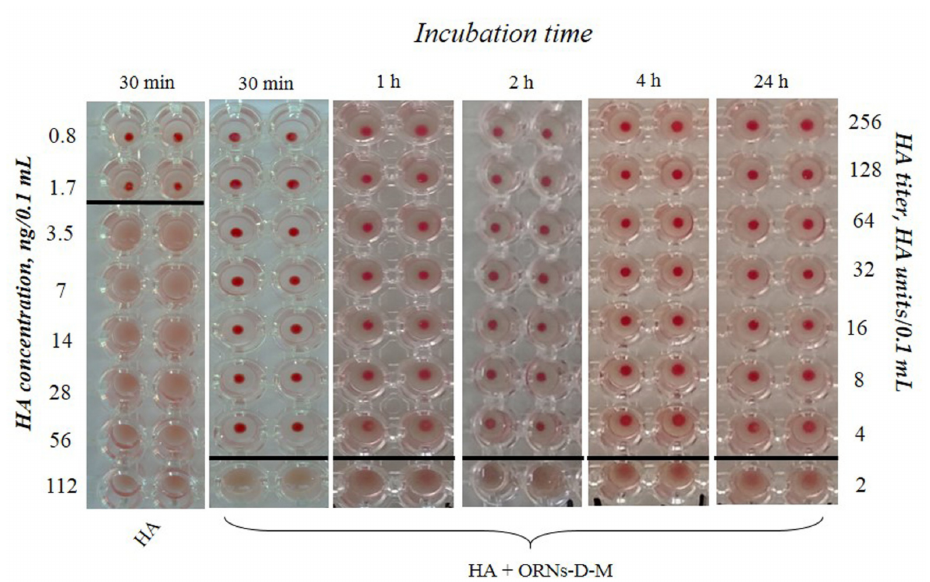
Figure 3. View of the hemagglutination reaction mixtures displayed in a round-bottomed microwell plate after the addition and dilution of the HA (Vaxigrip), which was pre-incubated with the ORNs- D-M (3.5 mg/mL) at the different duration of the experiment in hours. The HA titer was tested by HA assay. The picture shows one of five independent experiments.